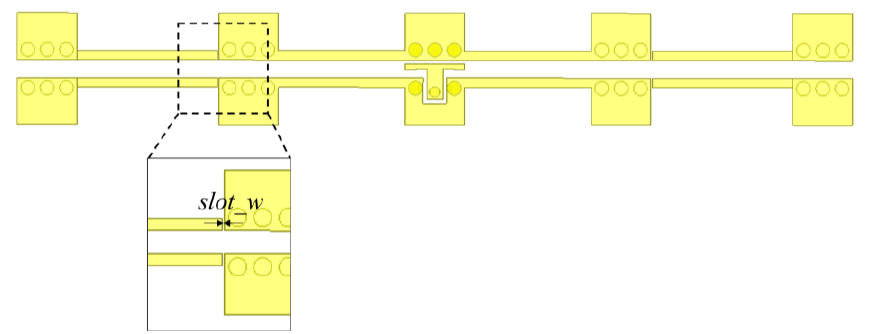
Figure 4. The 1-D 5 × 1 interconnected ME dipole array with slot.